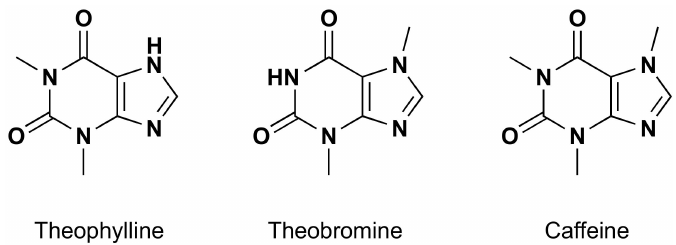
Figure 2. Natural methylxanthines: theophylline, theobromine and ca ff